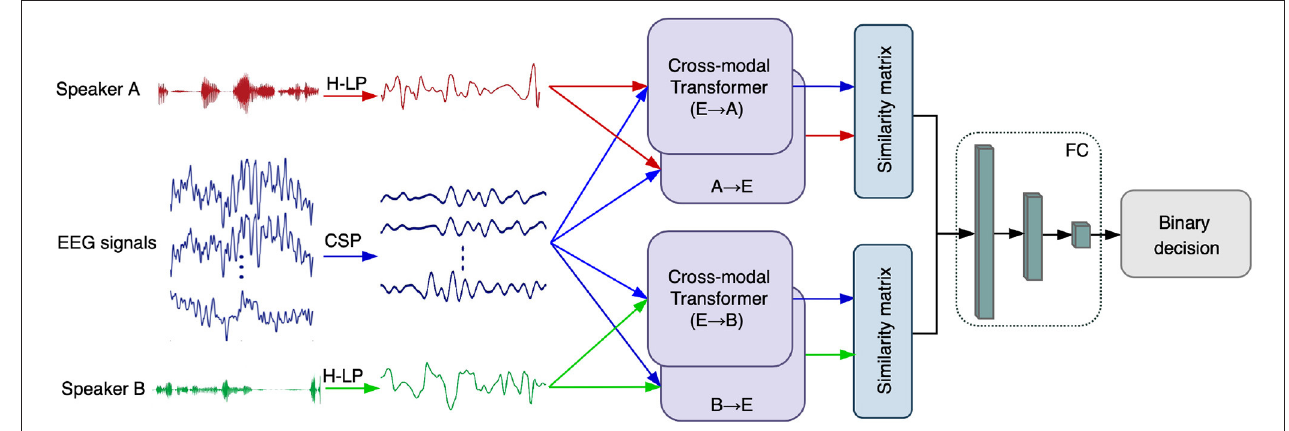
FIGURE 1 | A schematic diagram of our proposed cross-modal attention-based AAD network (CMAA). First, we employ CSP algorithm for EEG enhancement and H-LP to improve the speech envelope extraction process. Then, the cross-modal attention, which takes EEG and audio features as input, is the core component of the CMAA for dynamic interaction. The proposed CMAA architecture tackles all pairs of modalities with the cross-modal attention module, including EEG signals → audio of speaker A (E → A), EEG signals → audio of speaker B (E → B), audio of speaker A → EEG signals (A → E) and audio of speaker B → EEG signals (B → E). Finally, the cross-modal similarity are computed and compared to determine the attended speaker. Here, the audio streams of speaker A and speaker B are denoted in red and green, while the EEG signals are denoted in